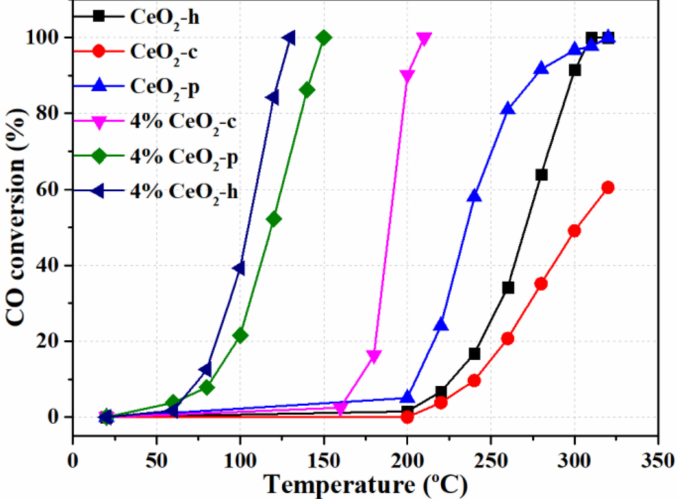
Figure 2. CO conversions of pure supports and catalysts with 4% Co loading prepared by di ff erent